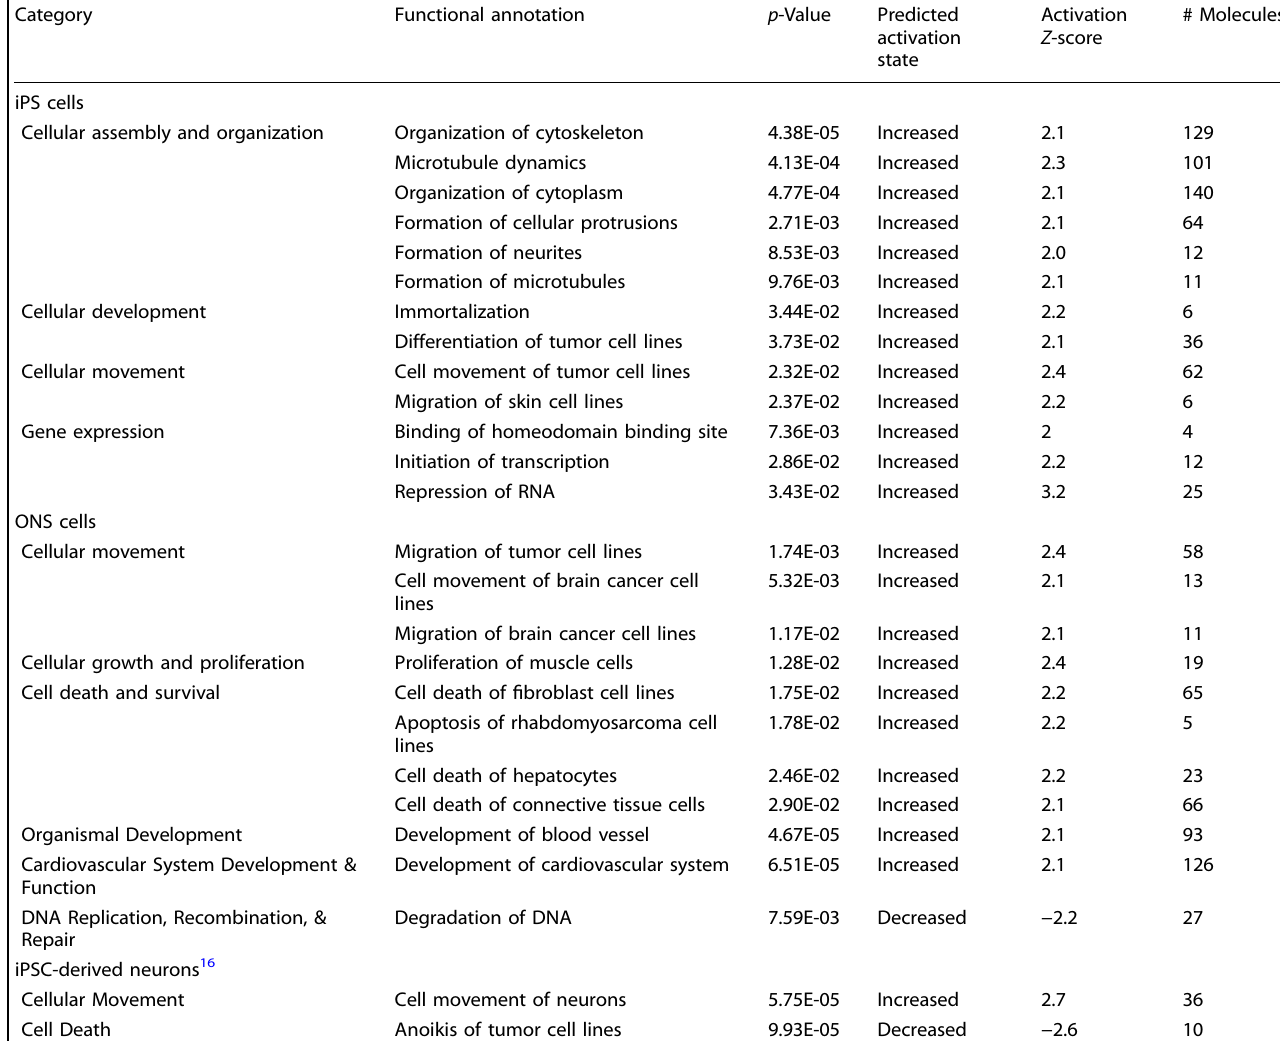
Table 2. GO categories of genes differentially expressed between patients and controls